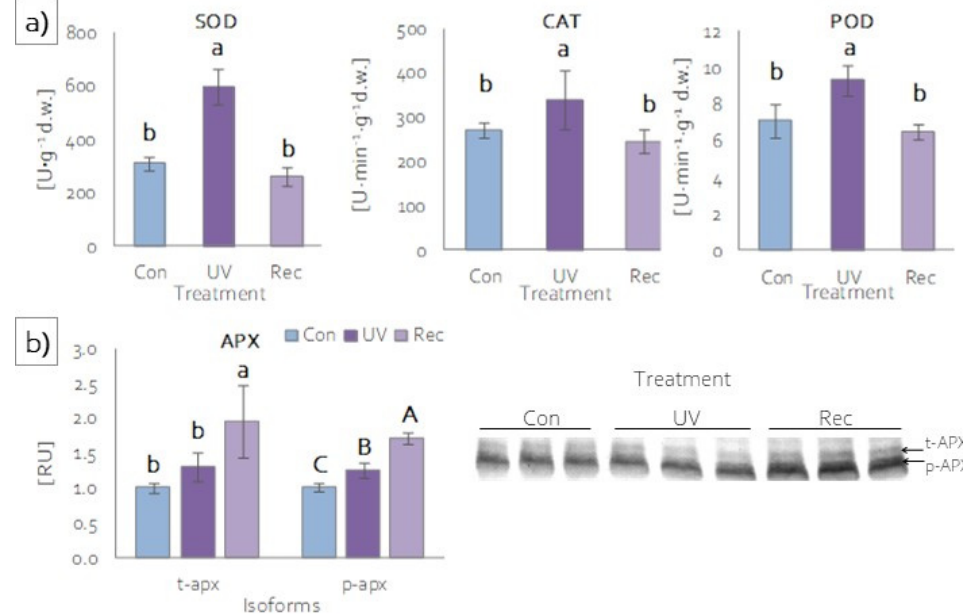
Figure 7. Activity and content of antioxidant enzymes of D. muscipula leaves under UV-A treatment: ( a ) activities of superoxide dismutase (SOD), catalase (CAT) and ( c ) guaiacol peroxidase (POD) ( n = 5); ( b ) content of ascorbic peroxidase isoforms ( n = 3); content of proteins expressed as relative units (RU); Con—control plants; UV—UV plants; Rec—recovery plants; different letters—statistically significant differences at p ≤ 0.05.